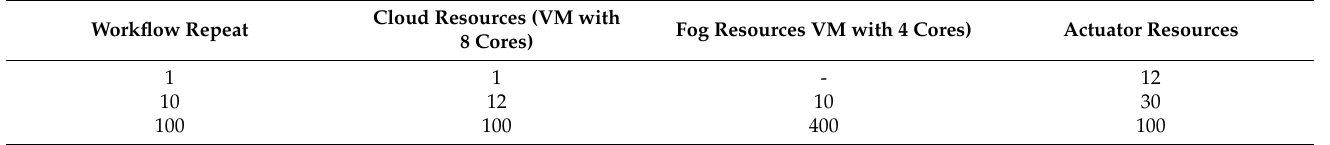
Table 3. Requirement of resources used in the evaluation